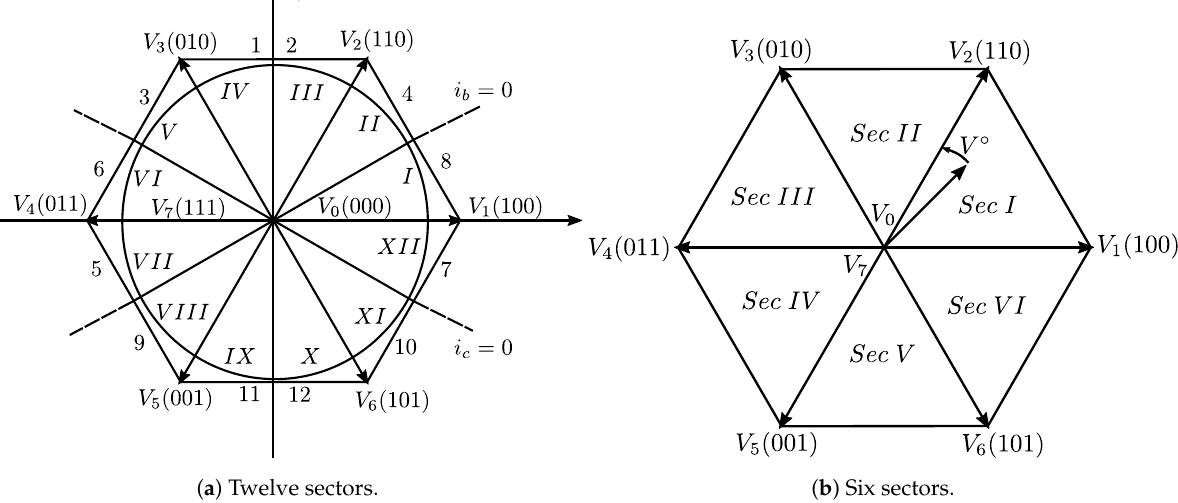
Figure 2. Fault partitioning schemes for a three-phase two-level converter with DC output. The sectors indicate the combinations of the switches. Eight combined states